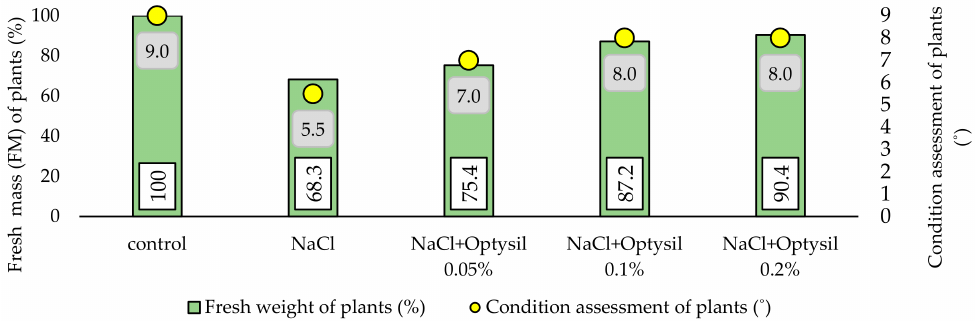
Figure 4. The effect of experiment factors on the fresh mass and the state of the oat